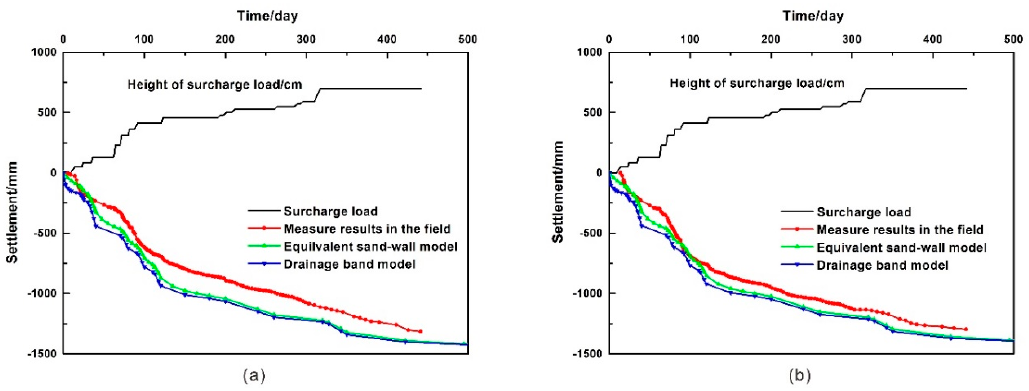
Figure 15. The settlement of the field monitoring test and numerical calculation: ( a ) CJ1-1; ( b ) CJ1-2.